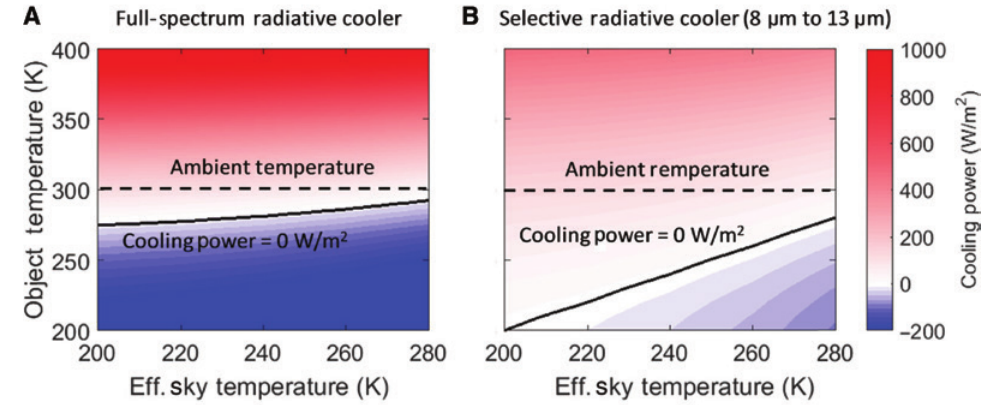
Figure 3: The net cooling power, as defined by Eq. (4), as a function of the object temperature and effective sky temperature for two cases: (A) a full-spectrum radiative cooler and (B) a selective radiative cooler. The horizontal dashed line indicates an ambient temperature of 300 K, and the black solid line illustrates zero cooling power. As in [49], sky radiation inside the atmospheric window is assumed to be emitted 3–5 km above ground at the effective sky temperature. The atmosphere is opaque outside the transparency window (8–13 μ m). For realistic non-zero atmospheric transmittance outside 8–13 μ m, full-spectrum radiative coolers may have slightly higher cooling power than selective radiative coolers (approx. 20 W/m 2 ) at ambient temperature